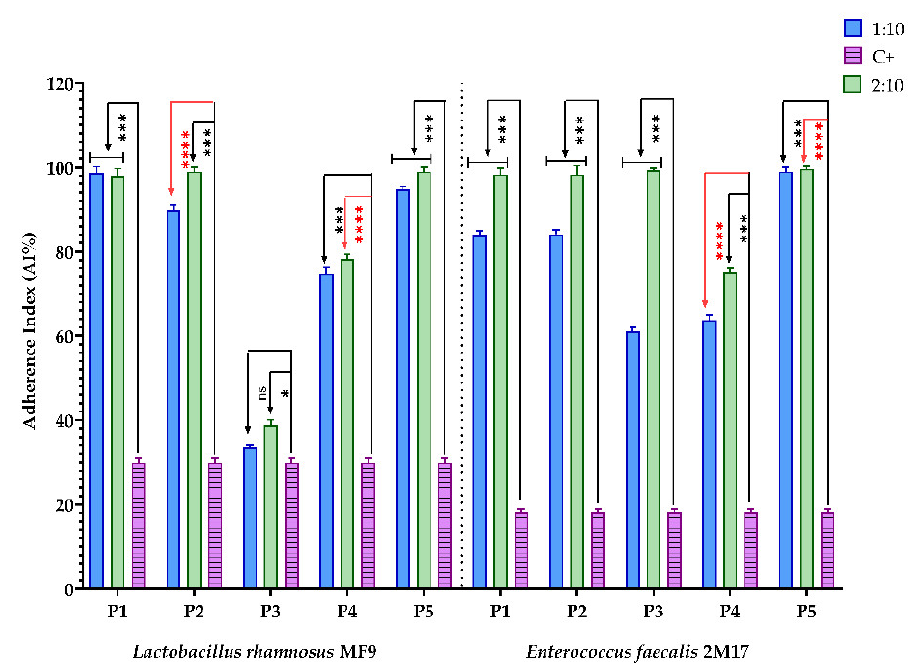
Figure 4. Graphic representation of AI% values representing the influence of BPE on the adherence capacity of the bacterial strains with probiotic potential; (P1–P5)-BPE samples; (C+)-bacterial adher- ence control. The significant impact of the effect of BPE on lactic strains was statistically analysed through one-way ANOVA and Dunnett’s multiple comparisons tests. (ns—not significant; * p ≤ 0.01; *** p < 0.001; **** p < 0.0001).